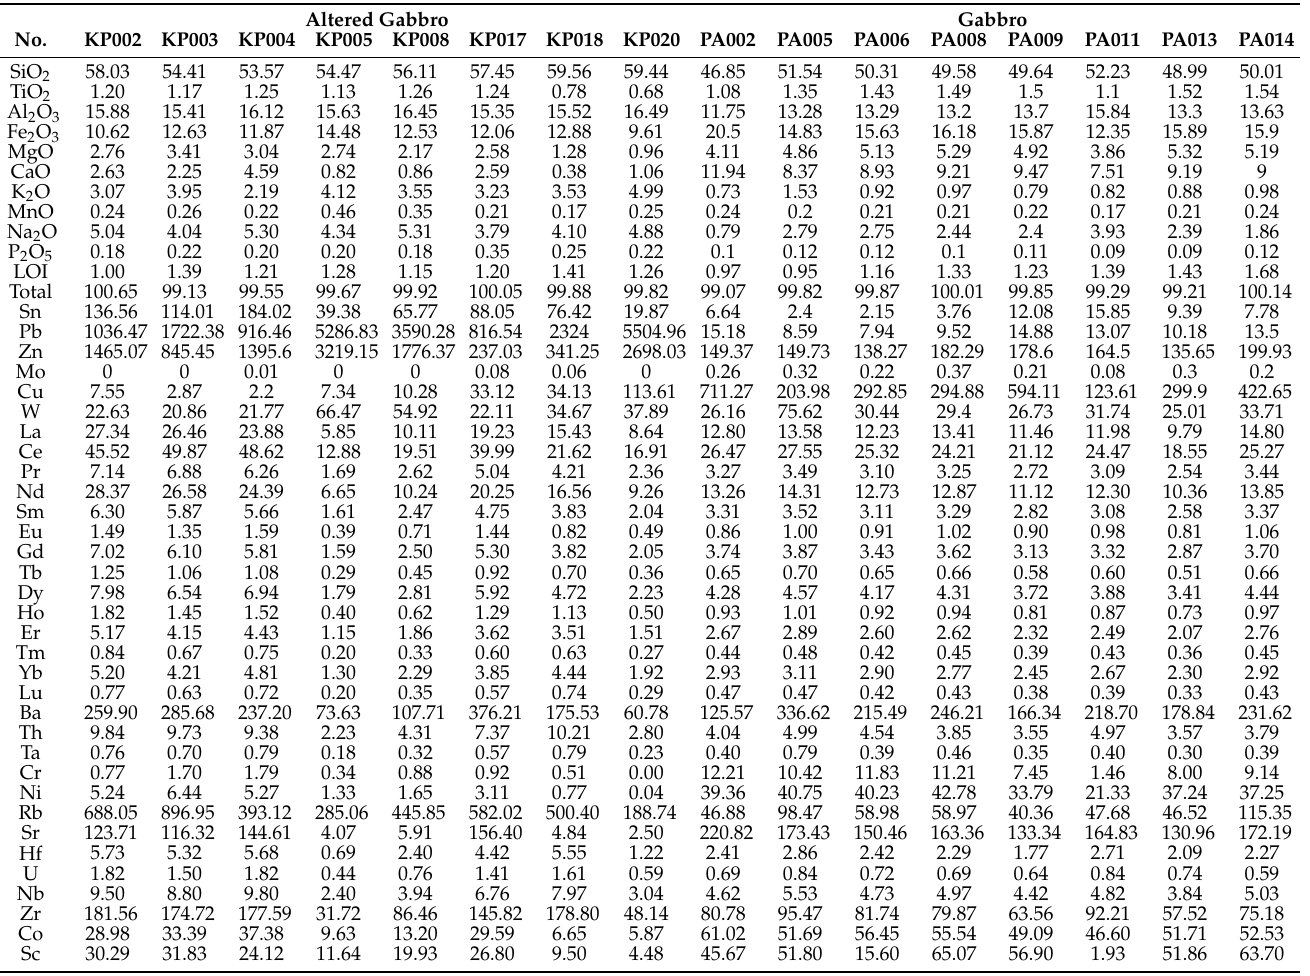
Table 1. Geochemical data for the studied